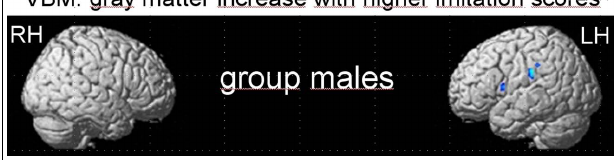
FIGURE 7 | Structural MR correlation effects (VBM): correlation of Hindi imitation score with gray matter volume yields a positive correlation in the male ( N = 20) subgroup; i.e., higher imitation scores correlate with increased gray matter volume in the left inferior parietal cortex (supramarginal gyrus; peak MNI voxel coordinates [ − 68/ − 24/29]) and left inferior frontal–premotor area (BA 44/BA 6; peak voxel coordinates [ − 59/8/11]). Statistical threshold: p < 0.05, corrected for multiple comparisons at FWE level within two regions of interest (ROIs) based on our fMRI results, an inferior left frontal ROI-sphere (r = 12mm) around [ − 54/6/30] and a left inferior parietal ROI-sphere (r = 15mm) around [ − 66/ −